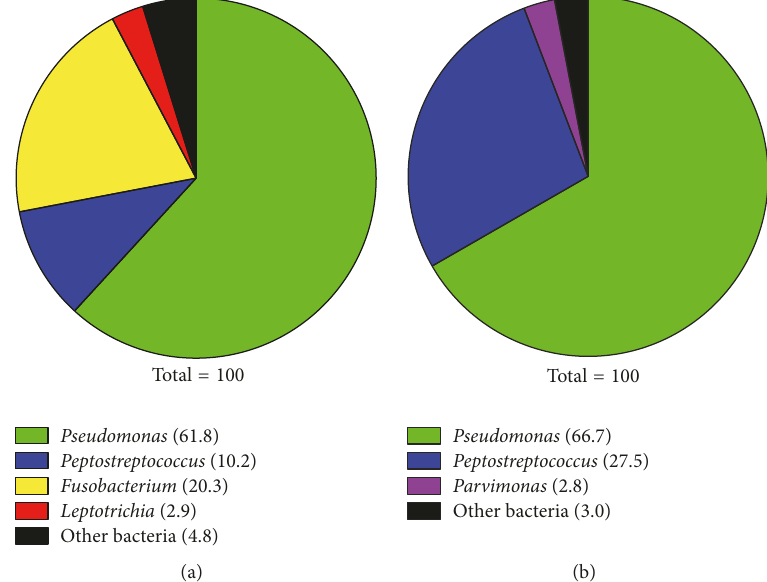
Figure 1: Distribution of major bacterial genera found within the ear fluid samples by deep parallel pyrosequencing. Numbers indicate the percentage of each genus present in fluid from (a) right ear and (b) left ear. Pseudomonas and Streptococcus are facultative anaerobes; Peptostreptococcus, Fusobacterium, Leptotrichia , and Parvimonas are obligate anaerobes. “Other bacteria” represent genera present at less than 2.5% each. The identities and relative abundance of these organisms are provided in Table 2. Table 1: Bacteria isolated from cultures of left and right ear fluid samples. Right ear fluid Left ear